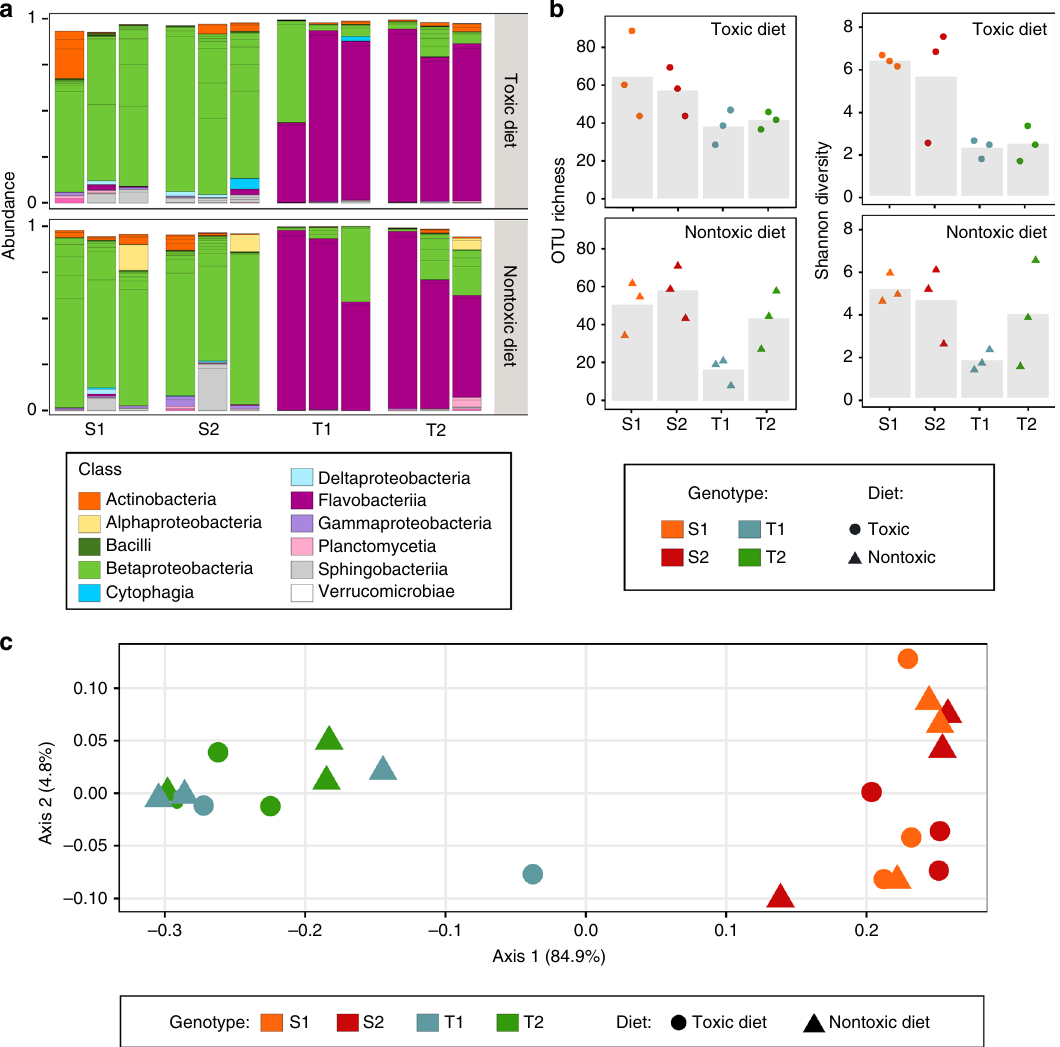
Fig. 4 Effect of host genotype and diet on Daphnia gut microbiota structure. The gut microbiota of donor populations described in Figs. 2 and 3, corresponding to tolerant ( T1 and T2 ) and susceptible ( S1 and S2 ) genotypes, exposed to either a toxic cyanobacterial diet or a nontoxic green algal diet, was characterized through next-generation sequencing ( n = 3 replicated populations per type of genotype × diet combination). For each population, the microbiota characterization was performed on a pool of 20 guts, obtained from adult individuals. a Relative abundance of OTUs in the gut microbiota of donor populations. Colors indicate the different bacterial classes. OTUs with an occurrence lower than 1% are not represented. b α -diversity (OTU richness and Shannon diversity) in the gut microbiota of donor populations. Bars indicate mean values, points indicate speci fi c values for each population. Whereas α -diversity was not affected by the diet ( p = 0.16 and 0.62 for species richness and Shannon diversity, respectively), it signi fi cantly differed between tolerant and susceptible genotypes, with a higher diversity in susceptible genotypes ( p = 0.0006 and 0.0002 for species richness and Shannon index, respectively). The effect of genotype nested within tolerance class (i.e., tolerant or susceptible) was not signi fi cant ( p = 0.18 and 0.32 for species richness and Shannon index, respectively). p values were obtained from an ANOVA. c Principal component analysis of Daphnia gut microbiota in donor populations, using weighted UniFrac distance. Tolerant genotypes ( T1 and T2 ) on one hand, and susceptible genotypes ( S1 and S2) on the other hand, form two distinct clusters. Most of the variation in gut microbiota composition was explained by this tolerant vs. susceptible genotype effect ( p = 0.001), while the diet did not have a signi fi cant impact ( p = 0.287). The effect of genotype nested within tolerance class (i.e., tolerant or susceptible) was not signi fi cant ( p = 0.84). p values were obtained from a permutation